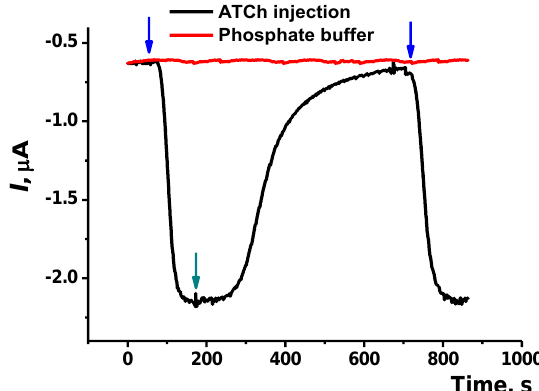
Figure 6. Dynamic response of the flow-through AChE biosensor to the 1.0 mM ATCh solution. Blue arrows correspond to the switching of the flow from the phosphate buffer to the substrate and the green arrow from the substrate to the phosphate buffer. Flow rate 0.2 mL/min.